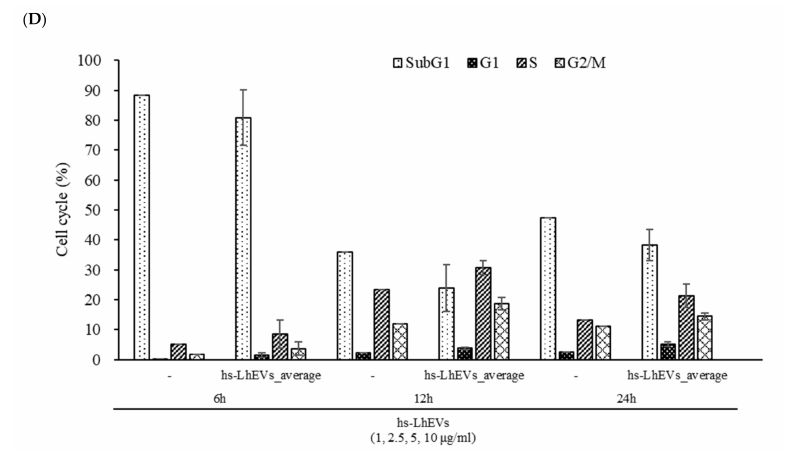
Figure 5. Analysis of the cell cycle status of hs- Lh EVs discussed in ( A – D ). HFDP cells were seeded in a 6-well plate at 3 × 10 5 cells in 2 mL/well and cultured with complete medium for 24 h. Cells were starved in serum-free medium for 16 h and treated with 1, 2.5, 5, and 10 µ g/mL of hs- Lh EVs for 6, 12, and 24 h in same conditioned medium. ( A ) Cell cycle histogram with propidium iodide (P.I) fluorescence profiles treated with hs- Lh EVs in dose- and time-dependent manners. ( B – D ) Analysis data of cell cycle shown in ( A ). Data are reported as mean ± SD of three independent